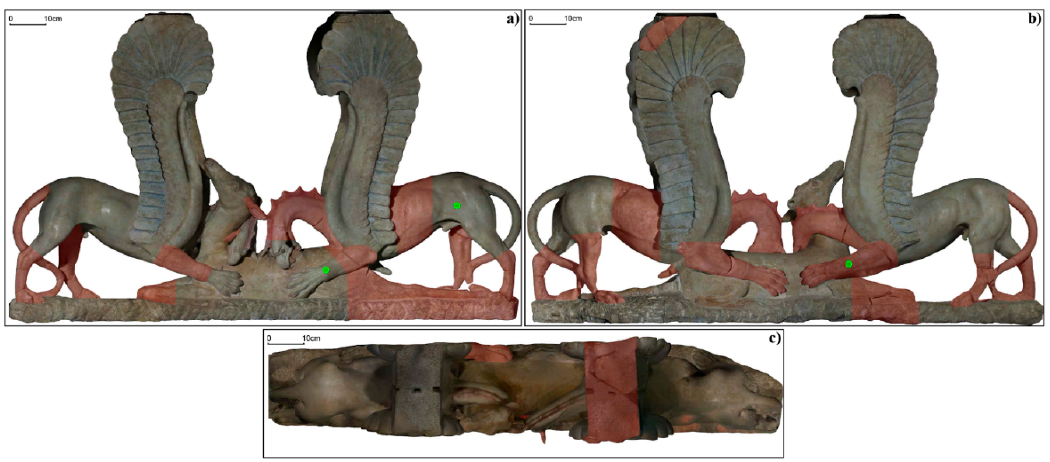
Figure 7. Details of the most significant microlesions ( a – g ).